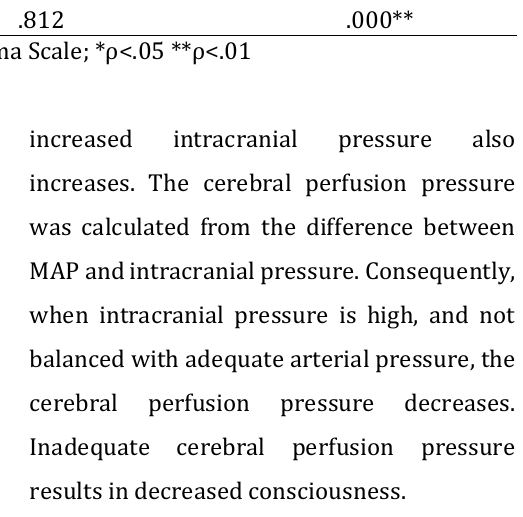
Table 4 The result of correlation analysis ( Spearman’s rho test) Correlation Coefficient p-value MAP-GCS .505 .004** Heart Rate-GCS -.279 .135 Respiratory Rate-GCS -.598 .000** Body Temperature-GCS -.432 .017* SpO 2 -GCS .812